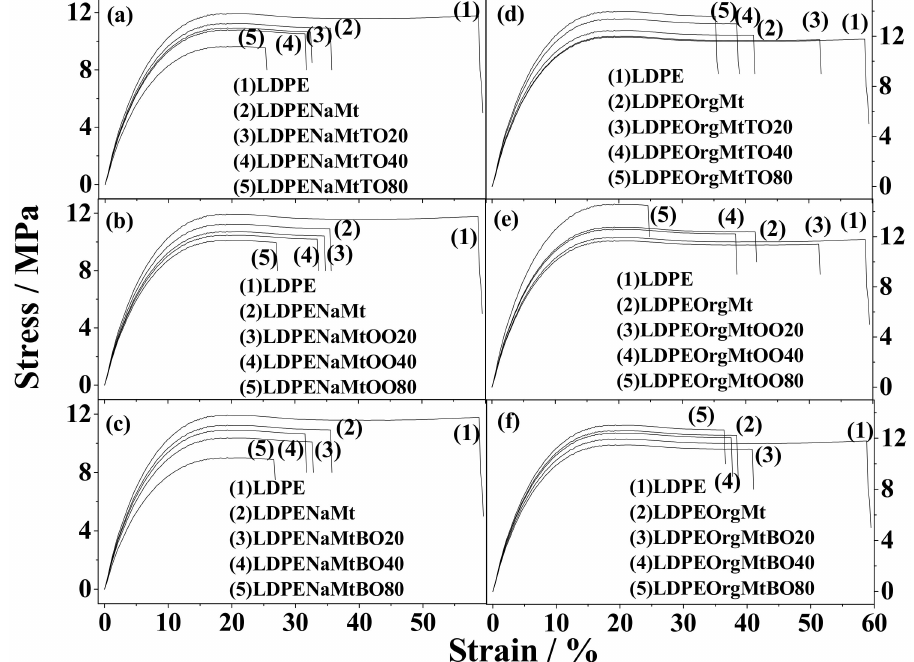
Figure 4. Stress-strain curves of all tested LDPENaMtEO (left part) and LDPEOrgMt films. ( a ) LDPENaMtTO films, ( b ) LDPENaMtOO films, ( c ) LDPENaMtBO films, ( d ) LDPEOrgMtTO films, ( e ) LDPEOrgMtOO films and ( f ) LDPEOrgMtBO